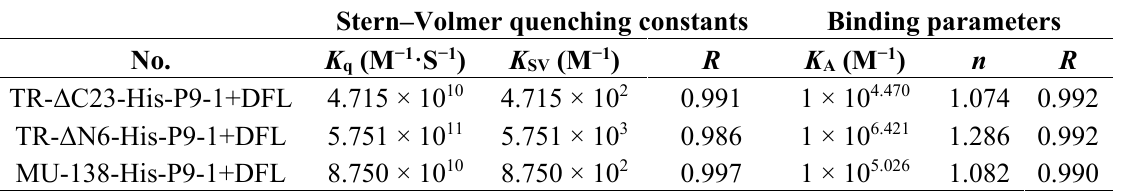
Table 4. Stern–Volmer quenching constants, binding parameters, and thermodynamic parameters of DFL to SRBSDV-P9-1 mutant